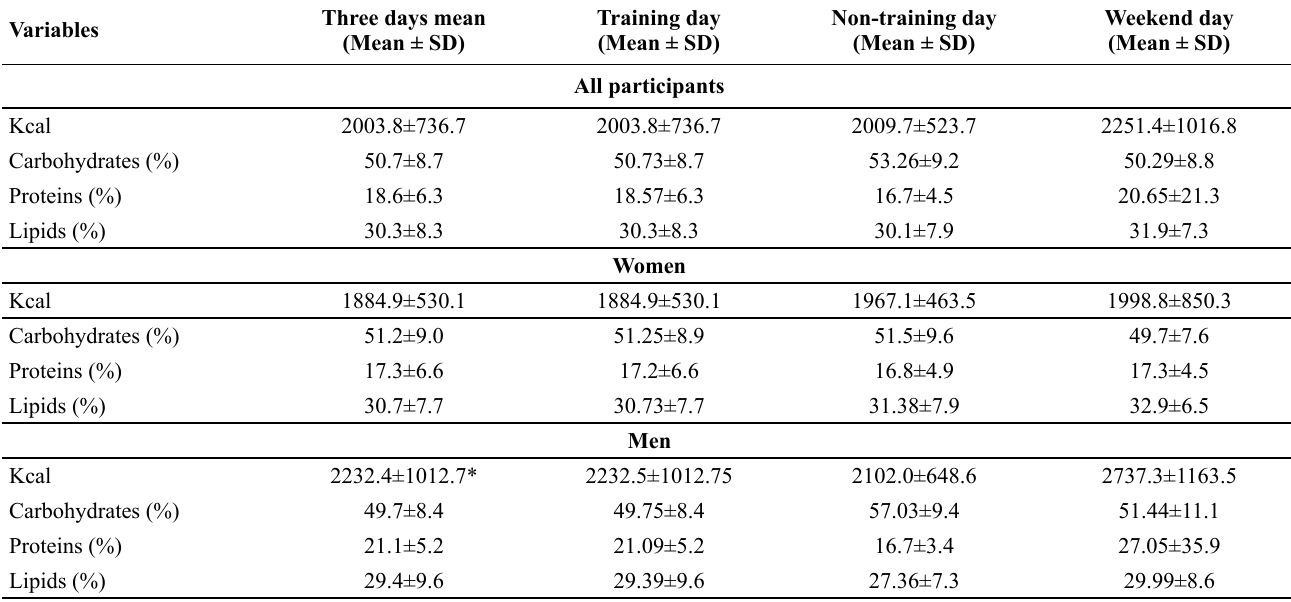
Table 2. Energy and macronutrient intake in physically active men and women.